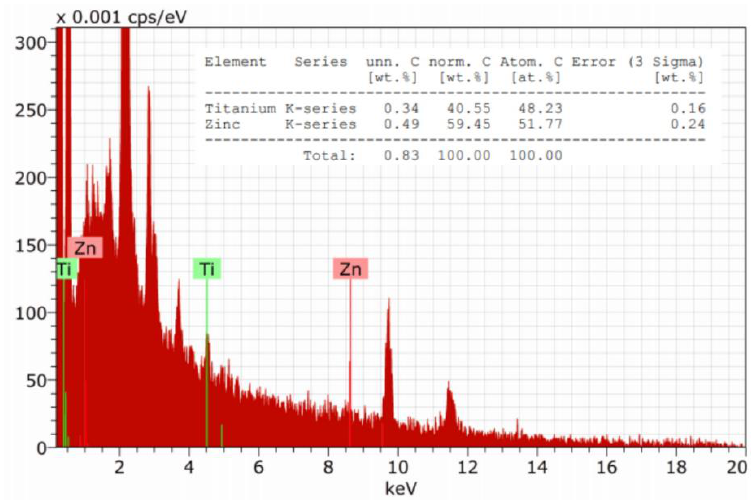
2 modified cotton terry towels.